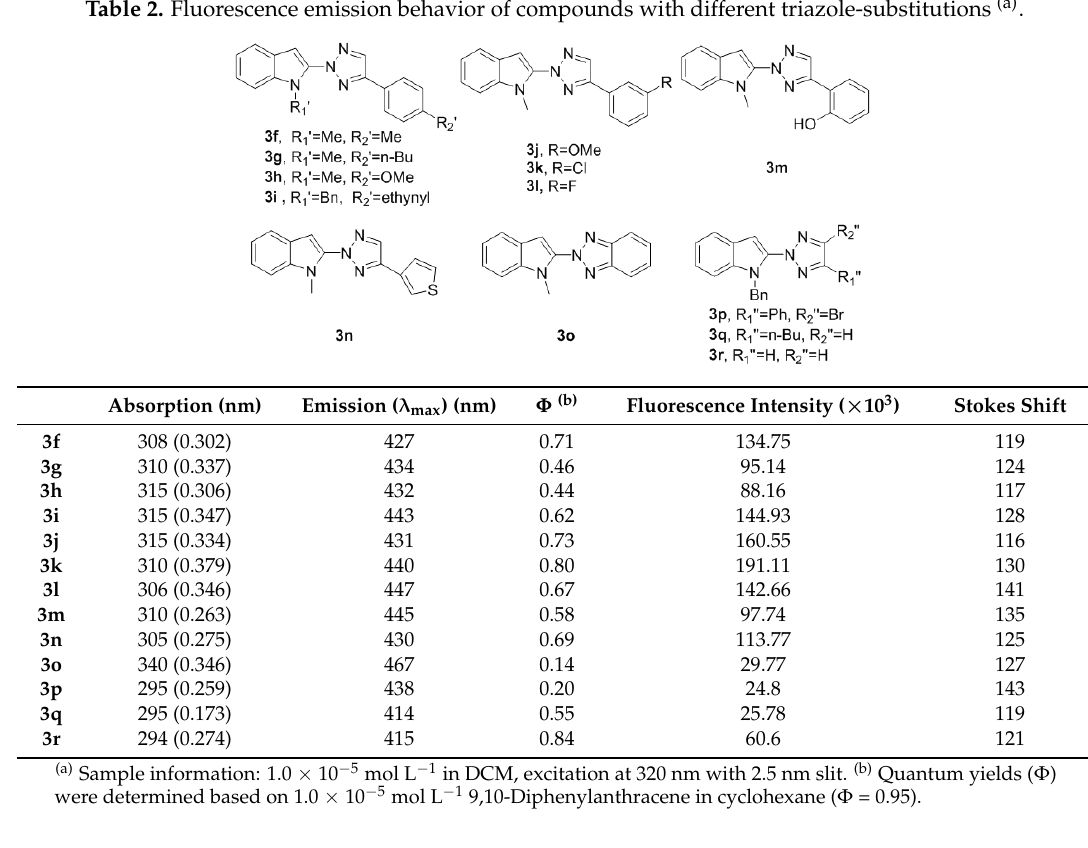
Table 2. Fluorescence emission behavior of compounds with different triazole-substitutions (a) .